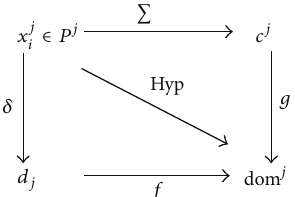
Figure 3: Graph representation of the morphological relations.